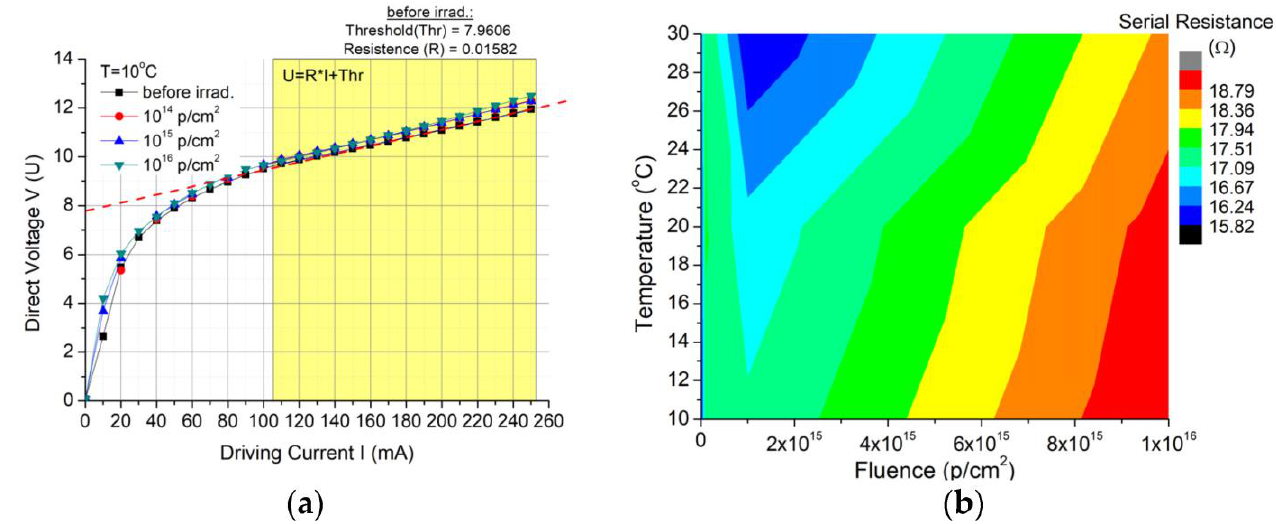
Figure 4. ( a ) Definition of the device serial resistance and ( b ) serial resistance variation with the radiation fluence and QCL case temperatures.